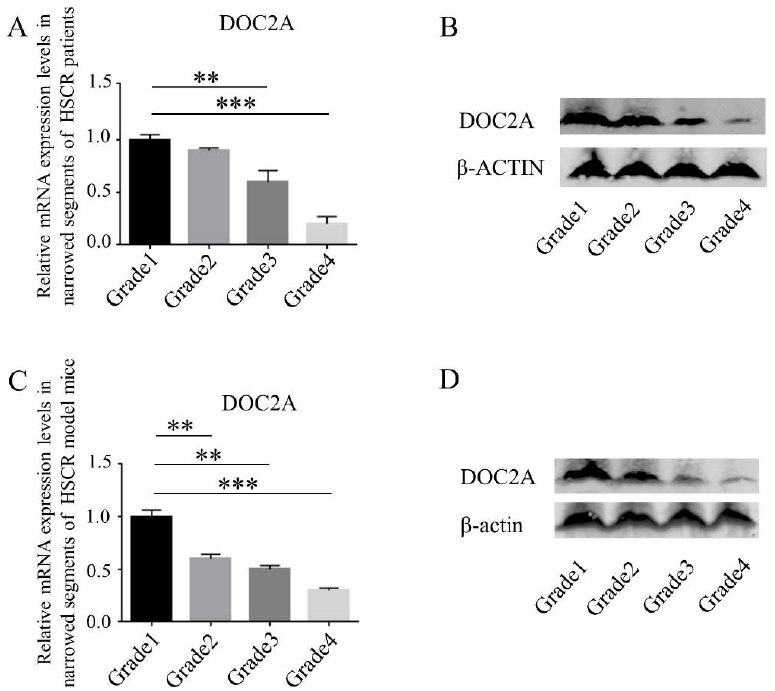
Figure 3. Relative expression levels of DOC2A in different grades. ( A , C ) Quantification of mRNA expression levels of DOC2A in different grades determined by RT-qPCR. ( B , D ) Protein expression